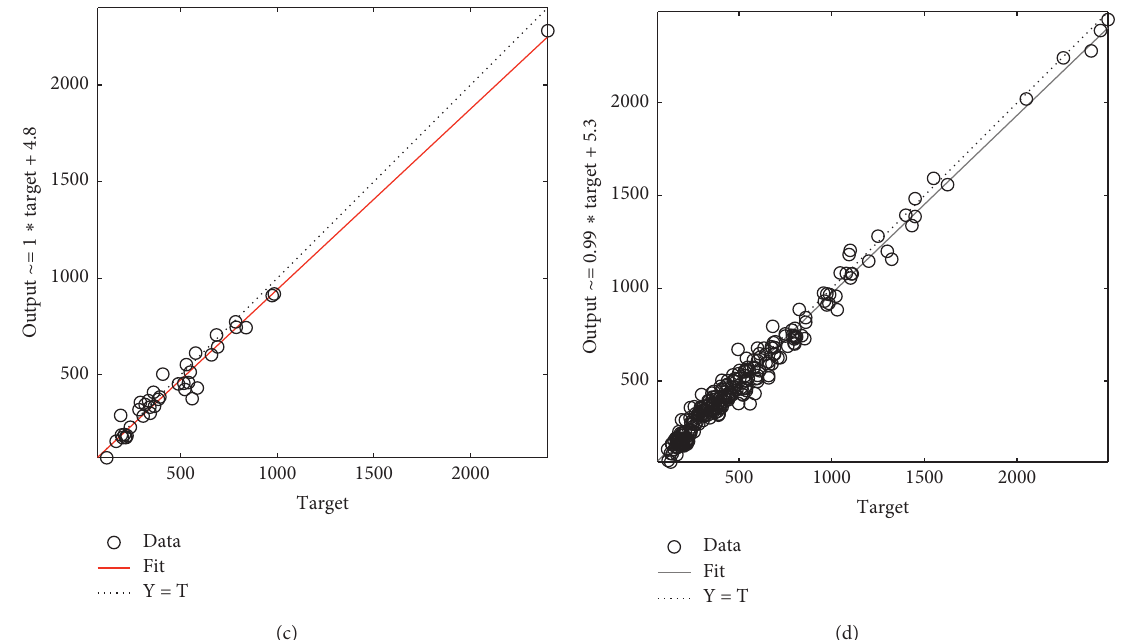
Figure 5: Linear regression between the neural network output and the expected output. (a) Training: R � 0.99663. (b) Validation: R � 0.98419. (c) Test: R � 0.98922. (d) All: R �